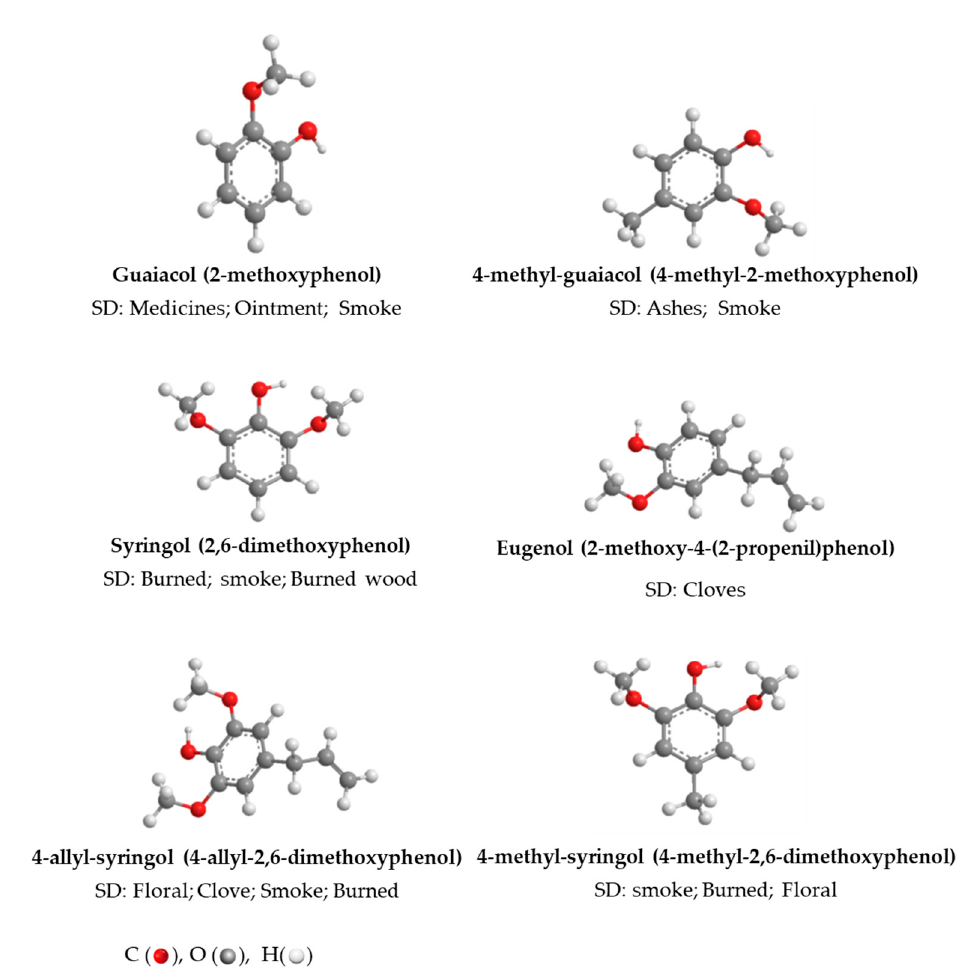
Figure 1. Chemical structure of volatile phenols studied in the AWS and their associated sensory descriptors (SD) [5].